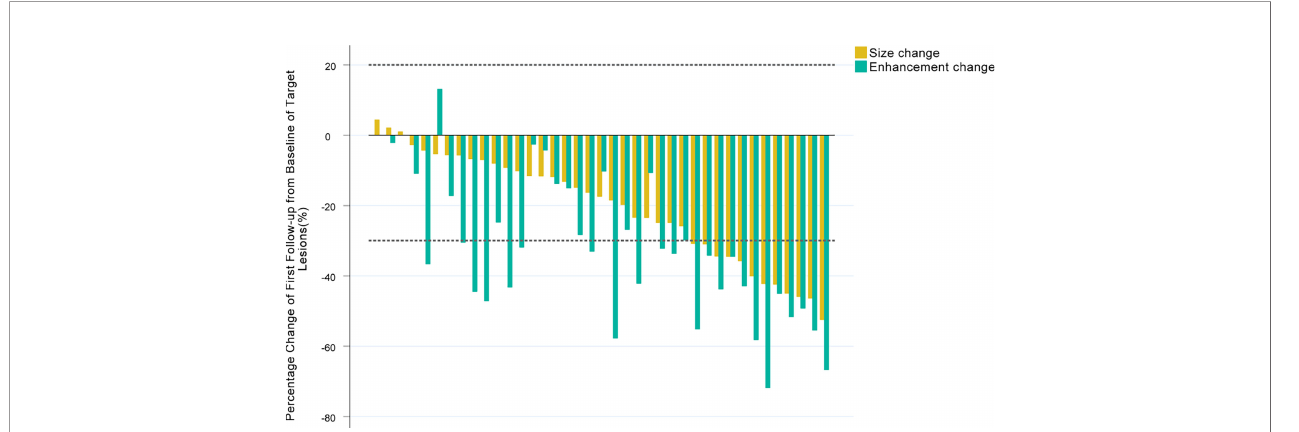
FIGURE 3 | Waterfall plots summarizing the maximum percent change from baseline in the SLD, the SLD of viable (enhancing) areas of all the target lesions on the fi rst follow-up CE-MRI scan after IMRT for each patient. The two adjacent bars in each group represent one patient. The dashed lines indicated size thresholds (+20%, -30%) for RECIST 1.1 and mRECIST